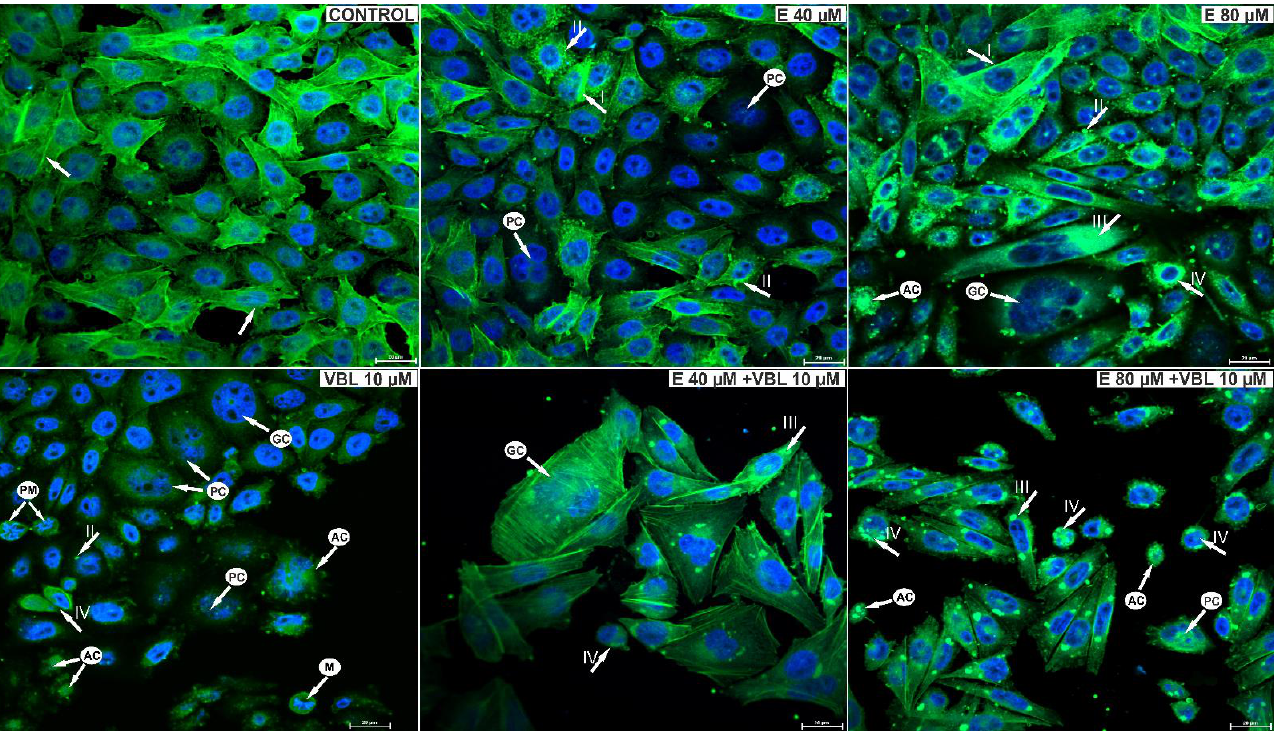
Figure 9 . Visualization of cytoskeleton elements in cells labeled with FITC-conjugated phalloidin and cell nuclei using DAPI. Control cells, with regular distribution of actin filaments (arrow) and the correct shape of the cell nuclei. Cells treated with 40 µM emodin, with increased fluorescence of actin filaments, often marginally distributed (arrow I) and small deposits of actin in the cytoplasm (arrow II). Cells treated with 80 µM emodin with reorganization of the cytoskeleton and actin deposited in the cytoplasm (arrow III). Cells in prometaphase (arrow IV), rounded, with damaged cytoskeleton after treatment with vinblastine (10 µM). Cells after the combined action of vinblastine (10 µM) and emodin (40 µM and 80 µM) with visible damage to the cytoskeleton and the presence of actin deposits. Also visible are rounded cells with condensed actin, giant multinucleated cells with reorganization of the cytoskeleton as an expression of a mitotic catastrophe and apoptotic cells. Explanation of abbreviations: PM — prometaphase cells; M — cells in metaphase; PC — multinucle-